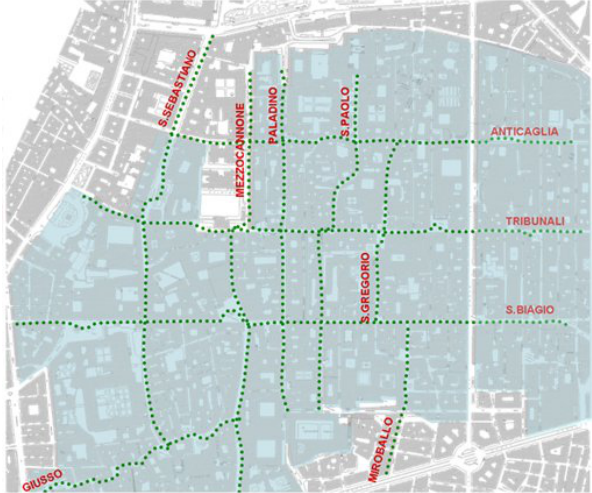
Figure 1: Naples Historic Centre: the LTZ in green and the selected paths for data